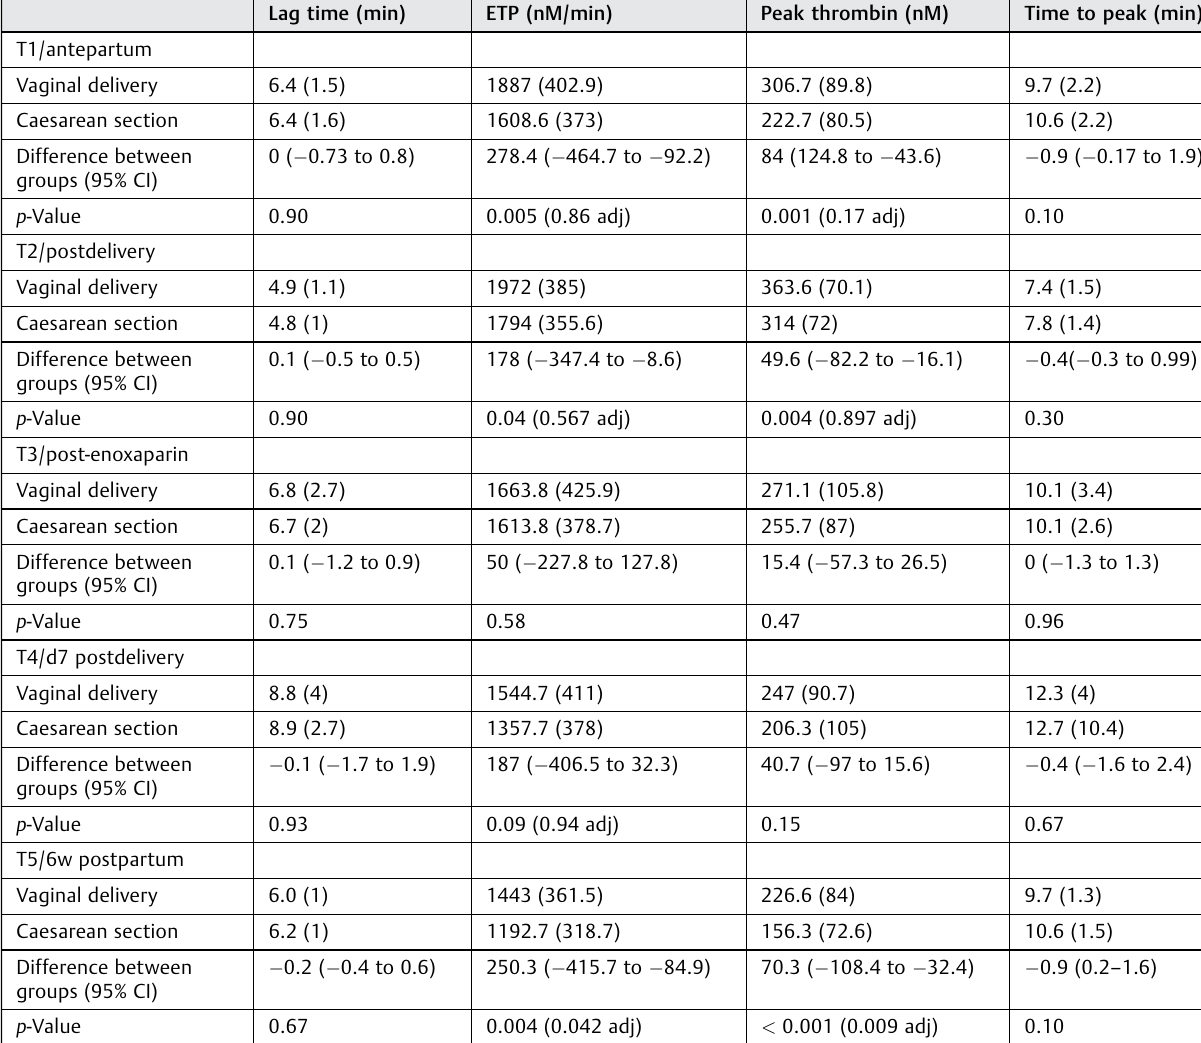
Table 4 Comparison of CT parameters between women with vaginal delivery compared with those with caesarean section, showing the means ¼ / – 1 SD for the values in each group Lag time